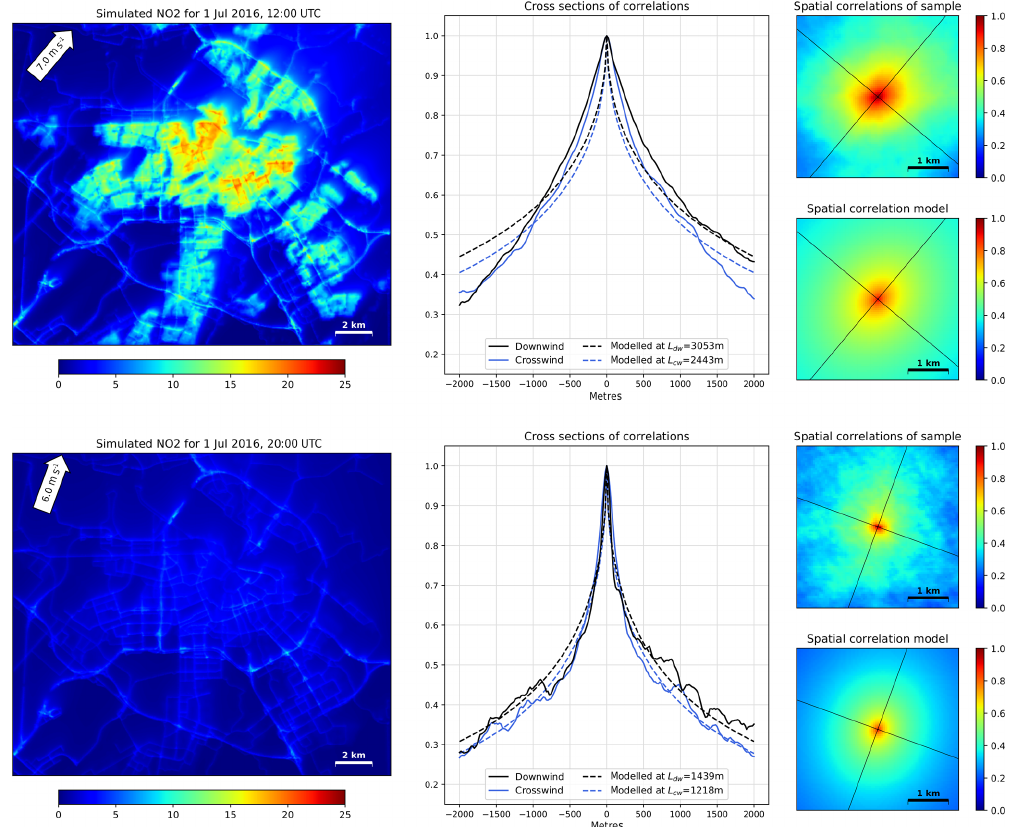
Figure 7. Left panels show simulated NO 2 concentration fields at 2 different hours. The middle panels show the spatial correlations along the downwind and crosswind axes based on a sample of n = 1000. The right panels show the spatial correlations of the sample and the resulting modelled spatial correlation